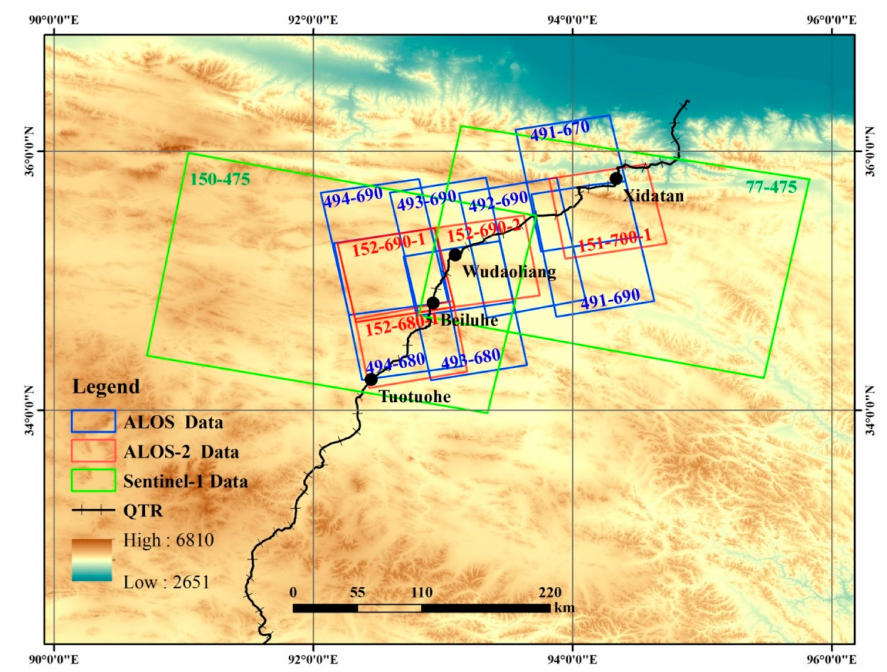
Figure 1. The study area with topography and surface traces of four overlapping ALOS ascending tracks, three ALOS-2 ascending tracks and two Sentinel-1 descending tracks in the northern